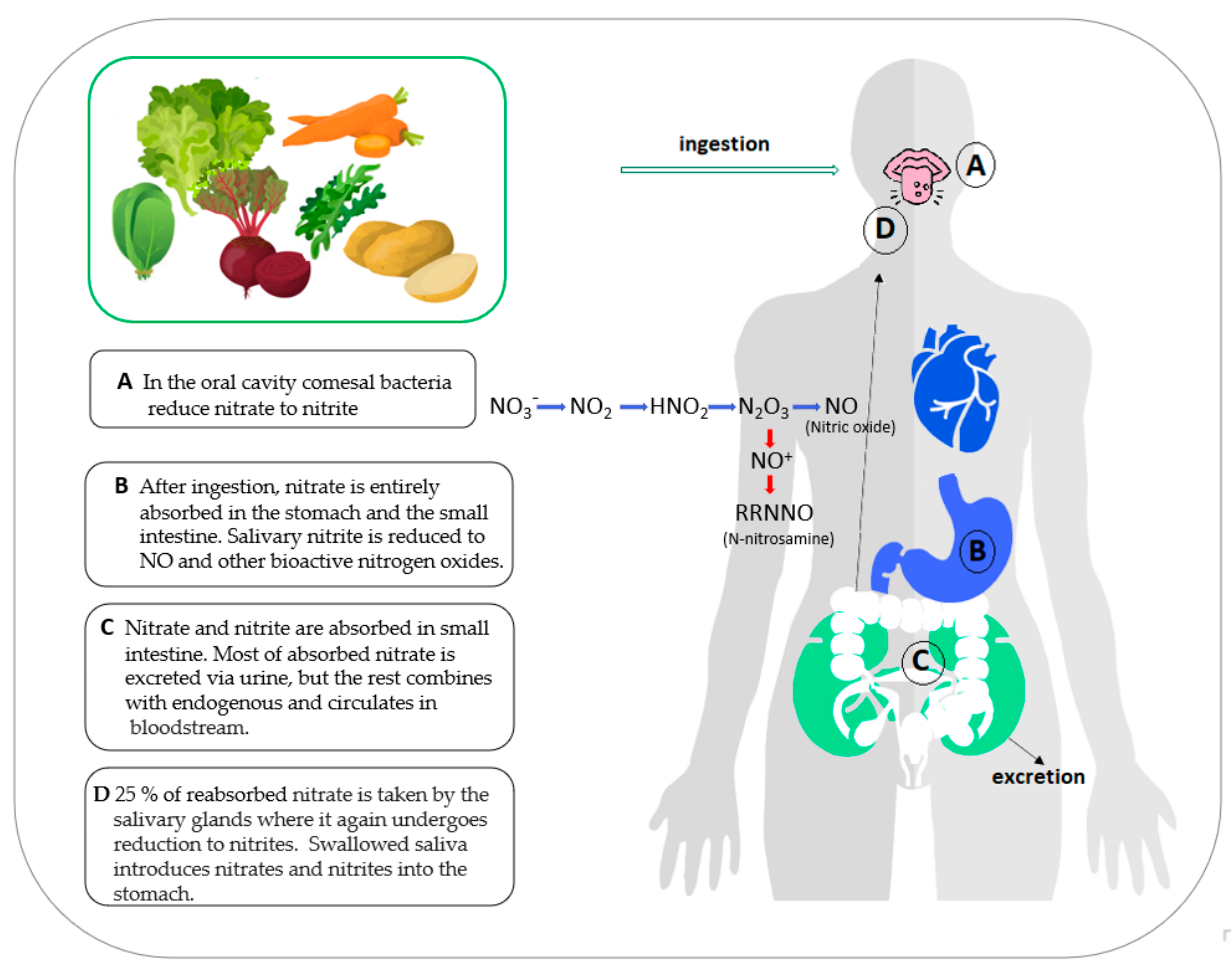
Figure 1. The entero-salivary circulation of nitrate and nitrite (NO 3 − , nitrate; NO 2 − , nitrite; HNO 2 , nitric acid; N 2 O 3 , dinitrogen trioxide; NO, nitric oxide; NO + , nitrosonium ion; RRNNO, reactive nitrogen intermediates).